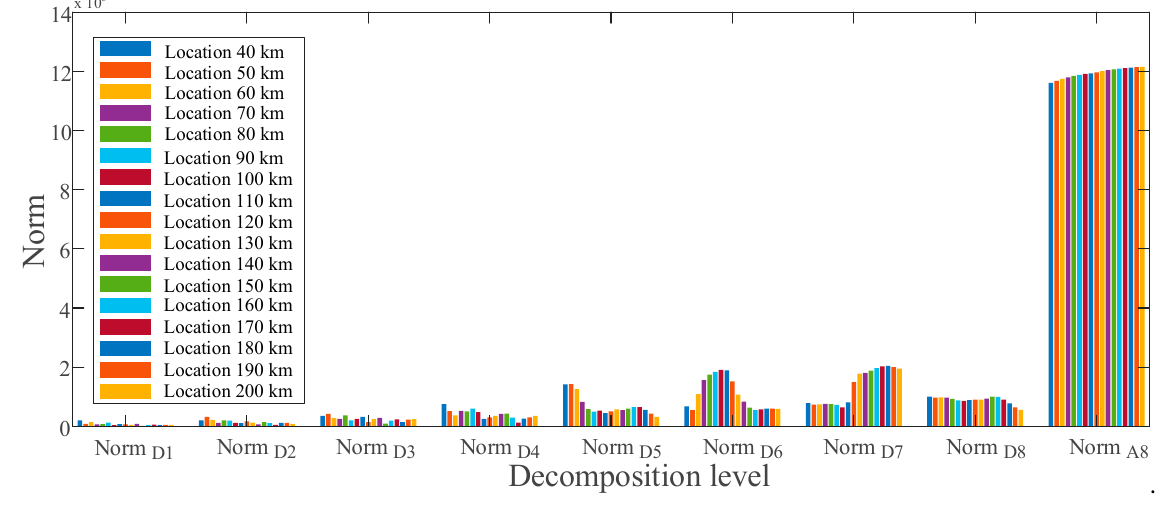
Figure 9. Feature vector extracted for ground fault at various locations of the voltage signal. In Figure 9, the norm values for each location are significantly different in the dominant frequency band between D5 and D8 and can be used as input vectors to establish fault estimation rules. Similarly, as illustrated in Figure 10, a unique signature of the pole-to-pole fault may be derived at different frequency bands. A schematic diagram for the feature vector development process is shown in Figure 11.